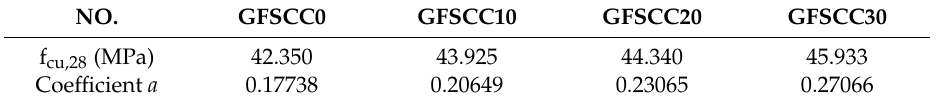
Table 7. Relationship between Coefficient a and Compressive Strength.